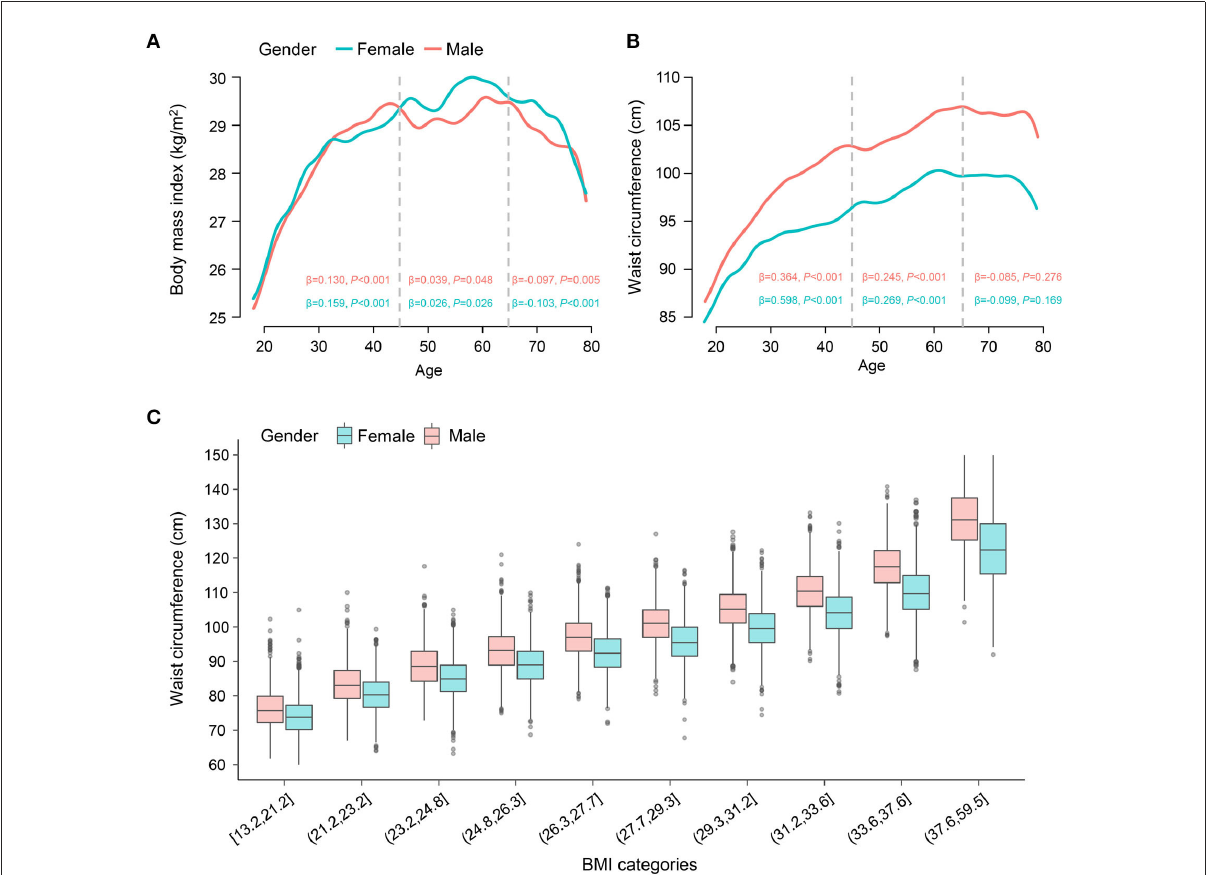
FIGURE3 Association of age with BMI and waist circumference. The smoothed curve on the association of age with (A) BMI and (B) waist circumference. The association of age with BMI and waist circumference is analyzed by a sex-specific survey-weighted generalized linear model in the young adults ( < 45 years old), middle-age adults (45–65 years old), and older adults ( ≥ 65 years old) individuals, respectively. The β -coefficient with P -value is provided. (C) Boxplots on the distribution of waist circumference across BMI (ten categories) by gender. Weighted analysis was performed. BMI, body mass index